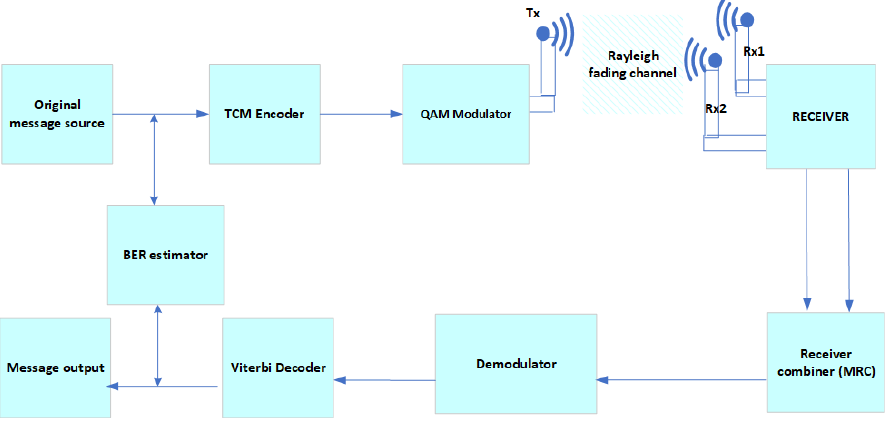
Figure 4. RX-TCM system